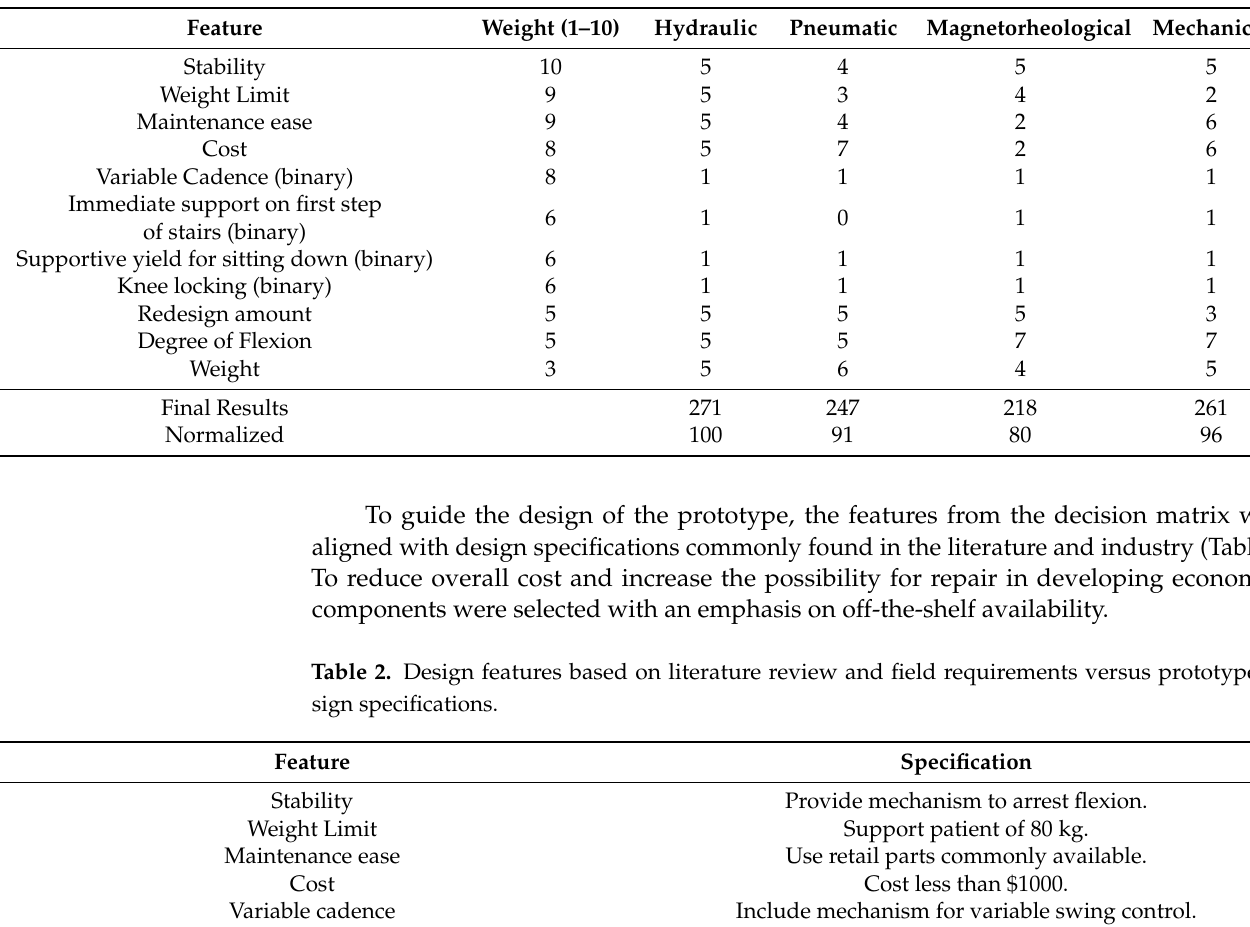
Table 1. Control method decision matrix for common features found in literature across four candi- date control methods. Each control method is scored per feature on either a one to nine scale or binary (yes or no) flag. Results were normalized to the highest scoring method for intuitive comparison.